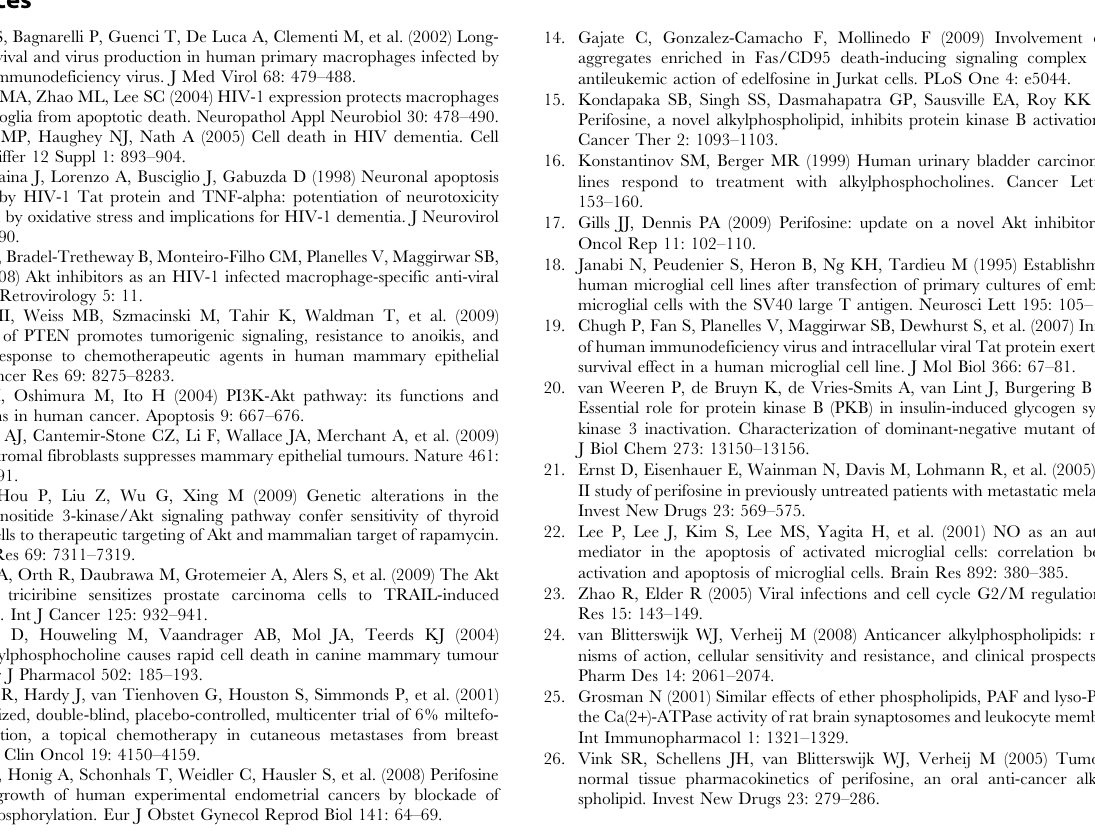
pCDNA3.1-hygro (-) or pTat101 ( + ) cells were analyzed by western blot for total (t) and phospho (p) specific Akt and GSK3 b , as described in Figure 3. The fold differences in the signals are